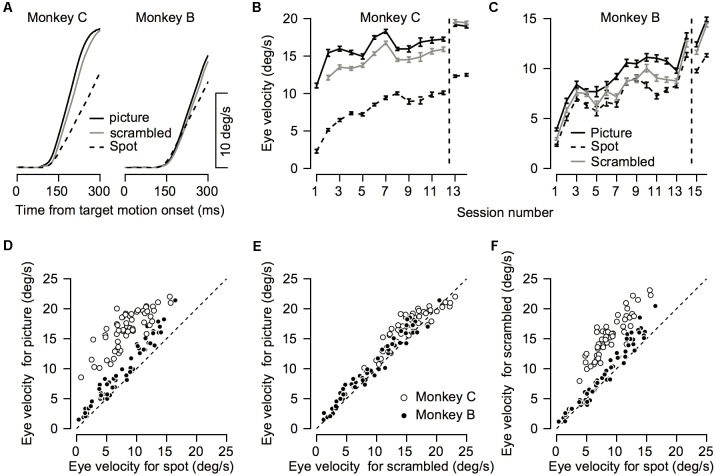
Comparison between pursuit initiation for the different targets. (A) Average eye velocity traces across all recording sessions for the picture (solid black), scrambled (gray), and spot (dashed) targets. Left and right plots show data for Monkeys C and B. (B,C) The progression over training days for eye velocity during pursuit initiation. The horizontal axis represents the session number. Values to the right of the vertical dotted line were recorded after extensive training on pursuit tasks. The vertical axis represents the average eye velocity across all target motion directions at 250 ms after target motion onset. (D–F) Quantitative comparison between target conditions. Each symbol shows the eye velocity at 250 ms after target motion onset; different symbols correspond to different sessions and different motion directions. Open and filled circles show the data for different monkeys. The plots present comparisons of the spot vs. the picture (D) the scrambled picture vs. the monkey picture (E), and the spot vs. the scrambled picture (F).